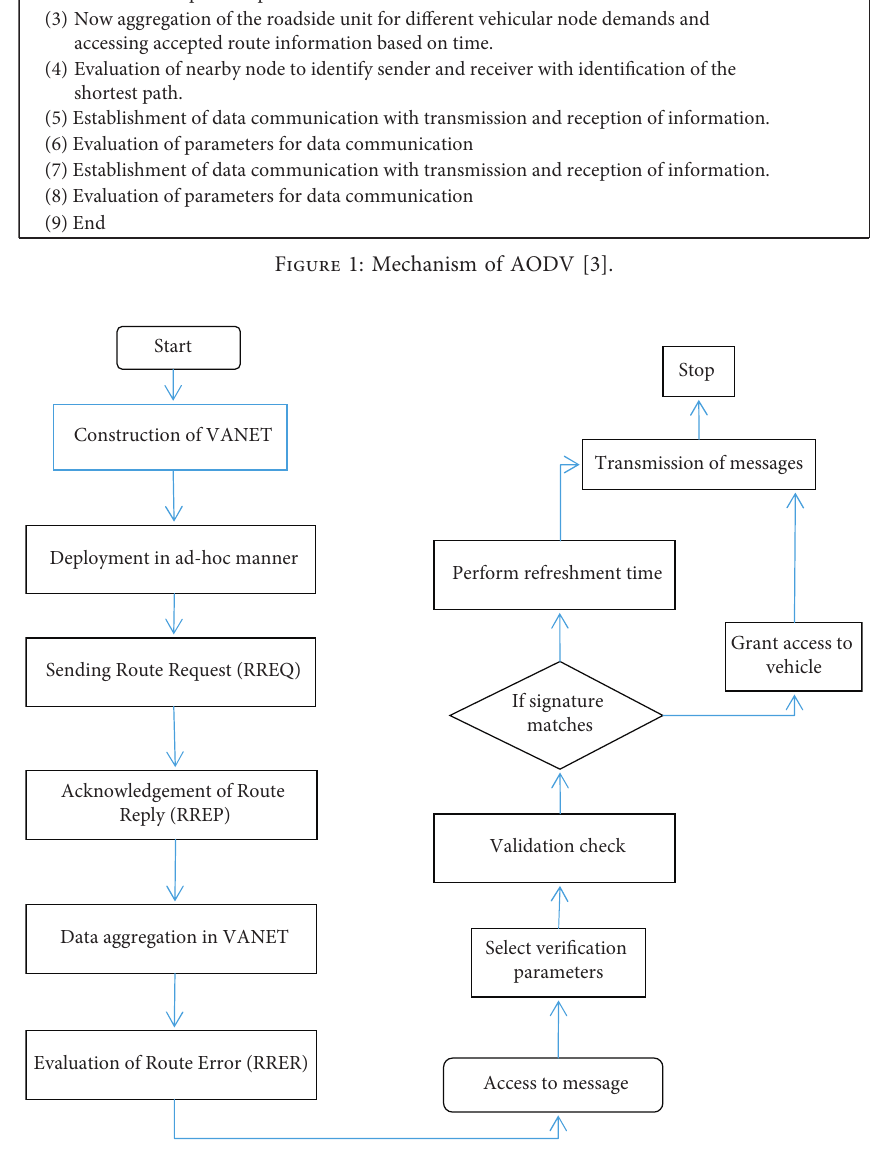
Figure 2: Flowchart for AODV